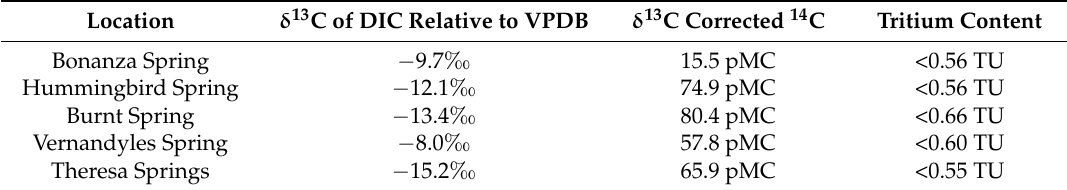
Table 2. Carbon isotope and tritium results for each of the sampled springs.